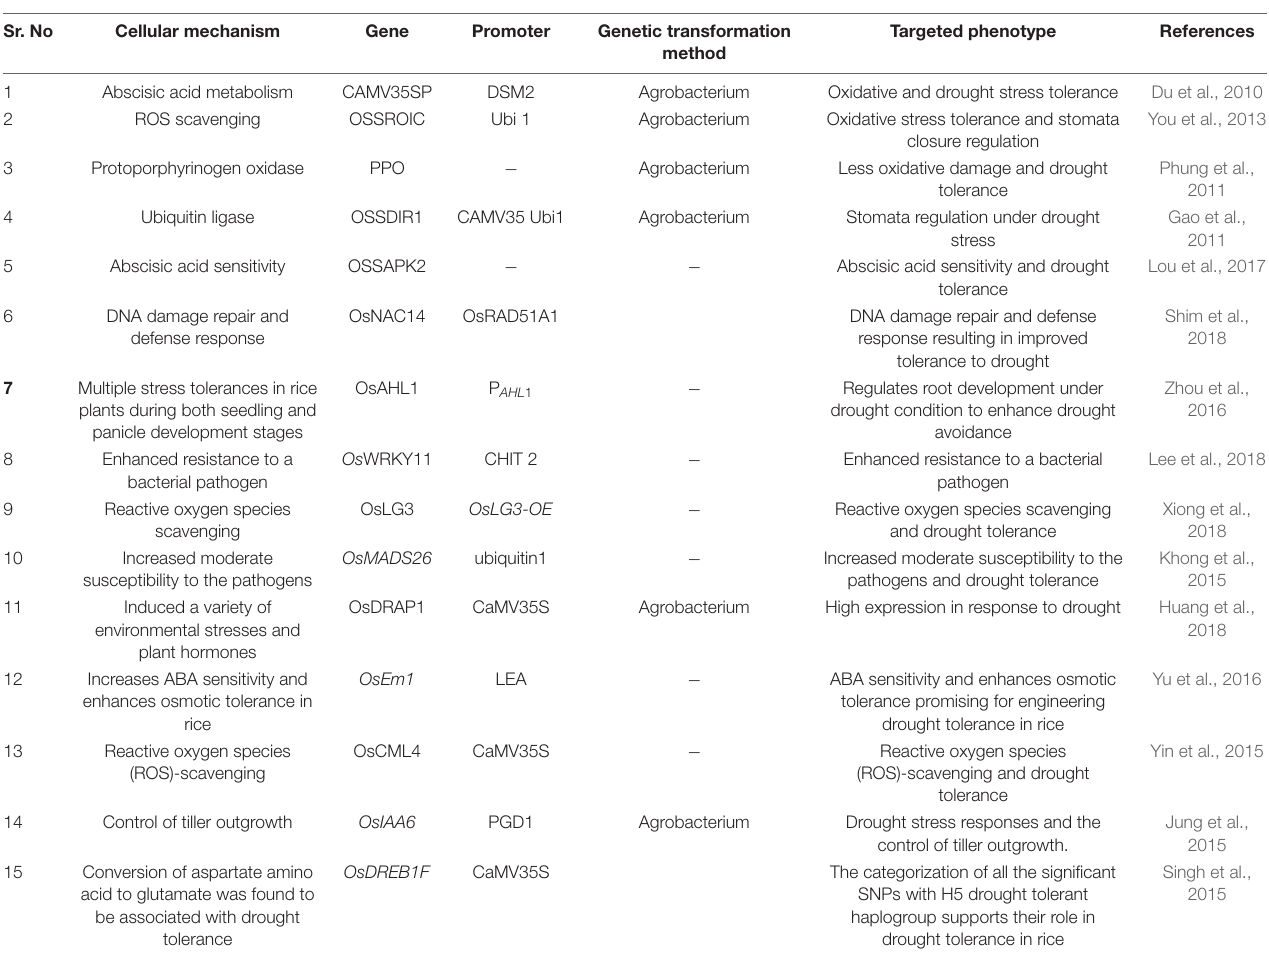
TABLE 1 | Drought tolerance genes that have been tested on rice. Sr.